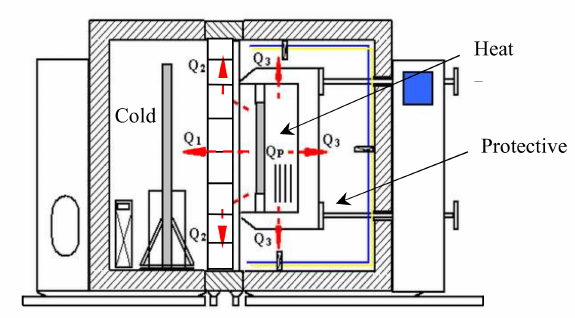
Figure 3. Testing schematic diagram for thermal